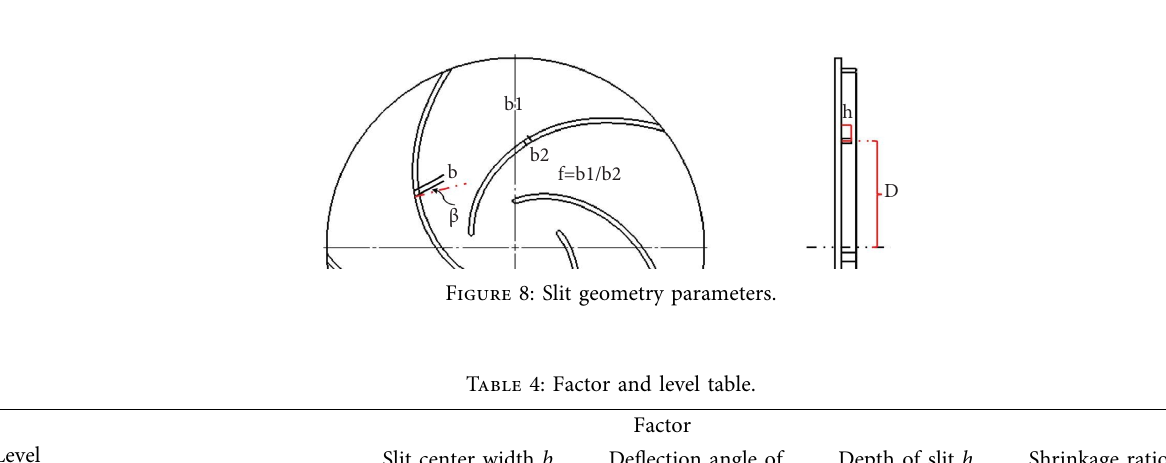
Figure 7: Velocity streamlines of the fow